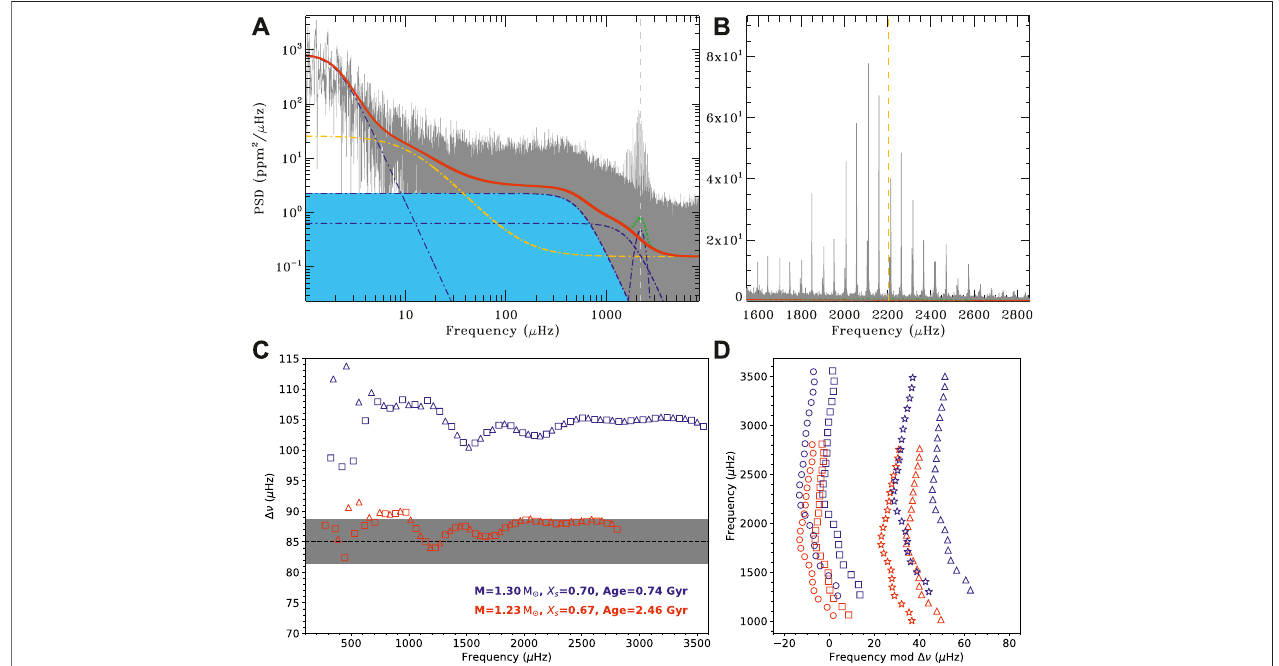
FIGURE 1 | (A) : An example of power spectral density (gray) for the solar-like star 16 Cyg A observed by Kepler . The solid red curve is a fi t to the background as obtainedbyCorsaroet al.(2020),consistingofthree Harvey-like pro fi les(bluedotted – dashed curves)plus whiteand colorednoise(yellow dotted – dashed line).Aglobal fi t to the oscillation power excess is shown by the blue dotted – dashed Gaussian curve and the net effect on the background is visible as a doted green curve. (B) : Observed frequency spectrum of 16 Cyg A centered in the frequency range around the frequency of maximum oscillation power (indicated with the yellow dashed line), showing the typical Gaussian-like shape. (C) : Large separation Δ ] as a function of the frequency for twotheoretical models (identi fi ed by red and blue colors) of the star GJ 504, chosen to fi t the spectroscopic parameters. The dashed line indicates the still uncertain observed value Δ ] =(85.0 ± 3.6) μ Hz, with the con fi dence interval shown by the gray shaded area. Different symbols are used to distinguish between the modes l =0 (squares) and l =1 (triangles). (D) : Échelle diagram for GJ 504 computed for the two models ofpanel C, with model ’ s average large separation values Δ ] =87.8 μ Hz (blue color model) and Δ ] =104.5 μ Hz (red color model) (Di Mauro et al., 2022). Different symbols are used for modes with different harmonic degrees, squares for l =0, triangles for l =1, circles for l =2 and stars for l